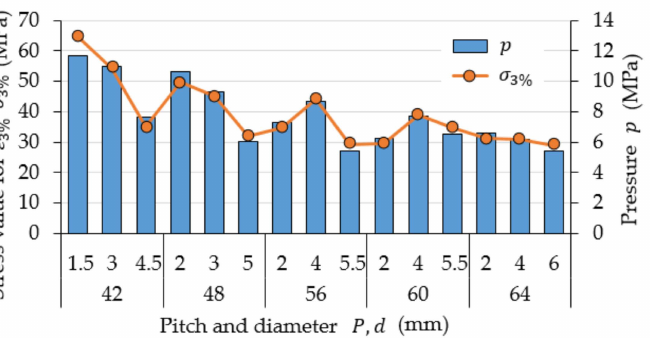
Figure 5. Stress values σ 3% that correspond to the strain value of ε 3% = 0.03 and contact stress p that is present at the interface between the lateral surfaces of the steel thread of the nut and the threaded